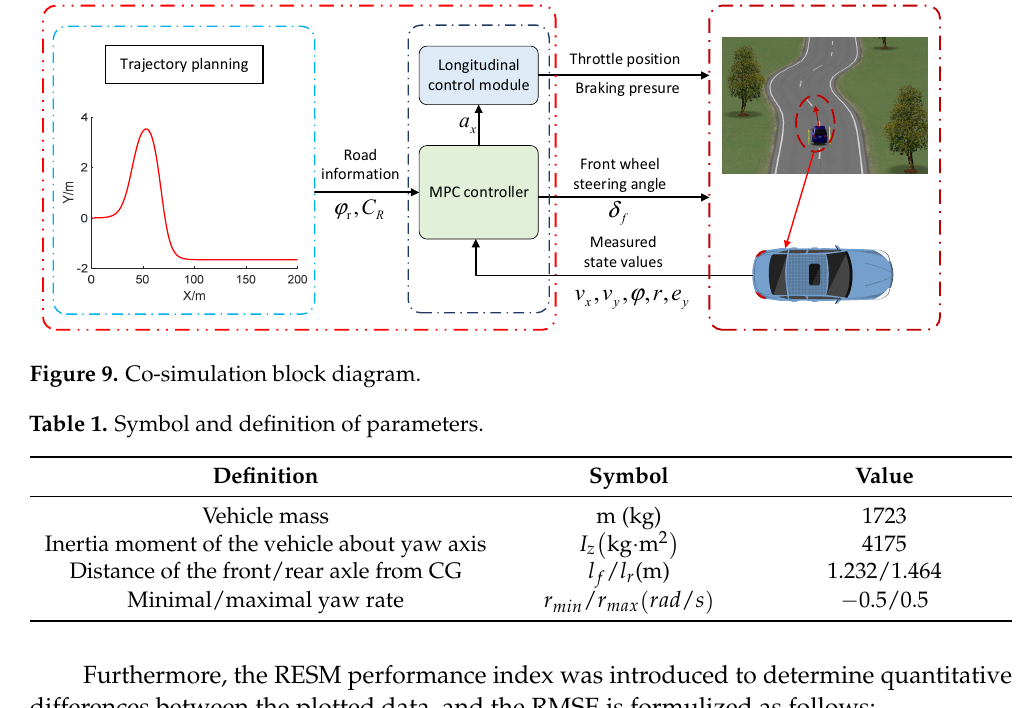
Figure 9 . Co-simulation block diagram.